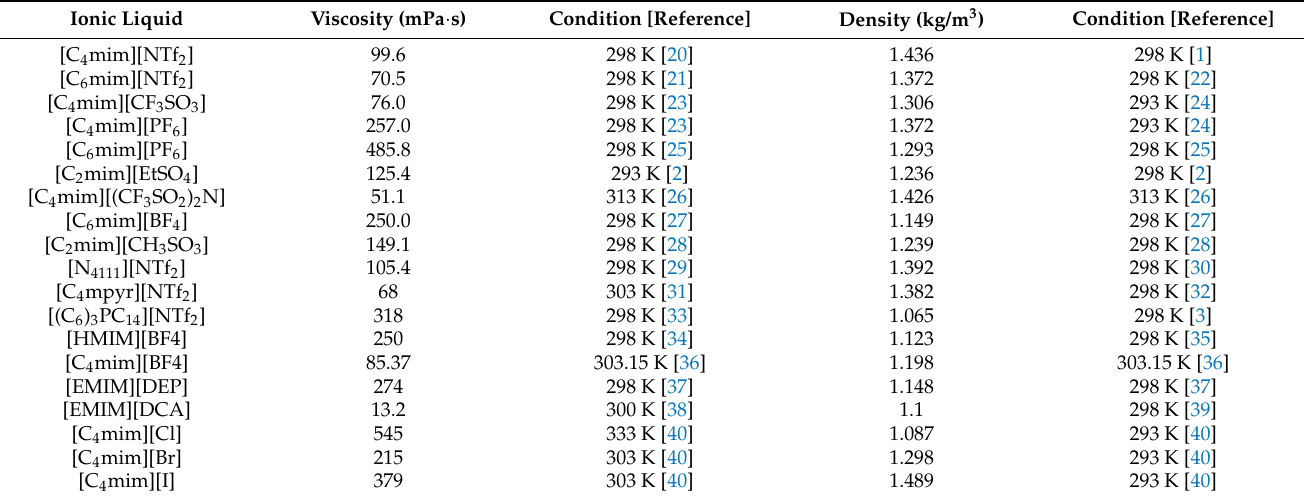
Table 1. Viscosity and density of ILs used as base fluids for INFs.